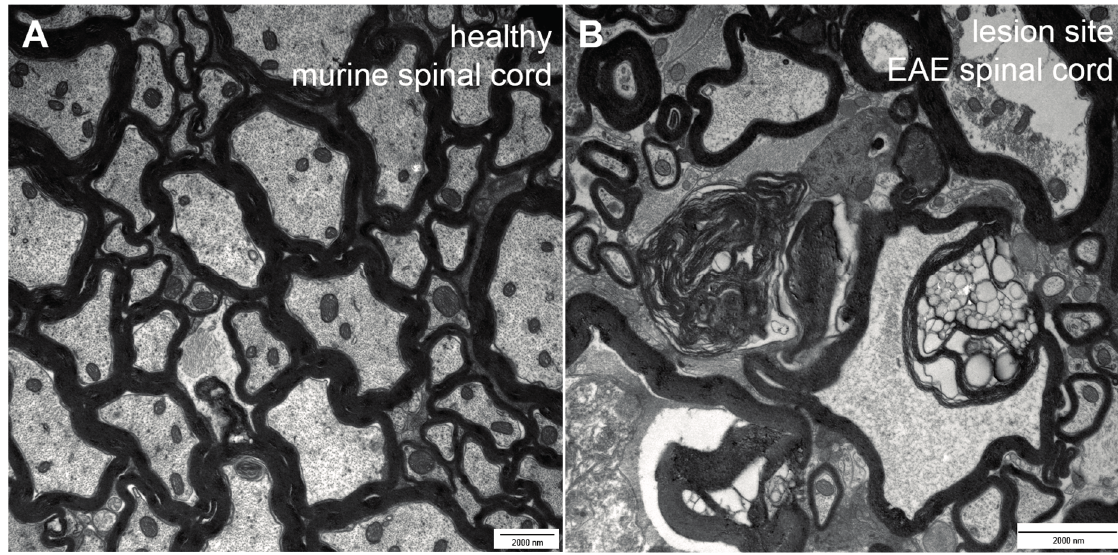
Figure 3. Comparison of healthy ( A ) versus EAE lesion ( B ) tissue taken from the murine spinal cord. EAE = experimental autoimmune